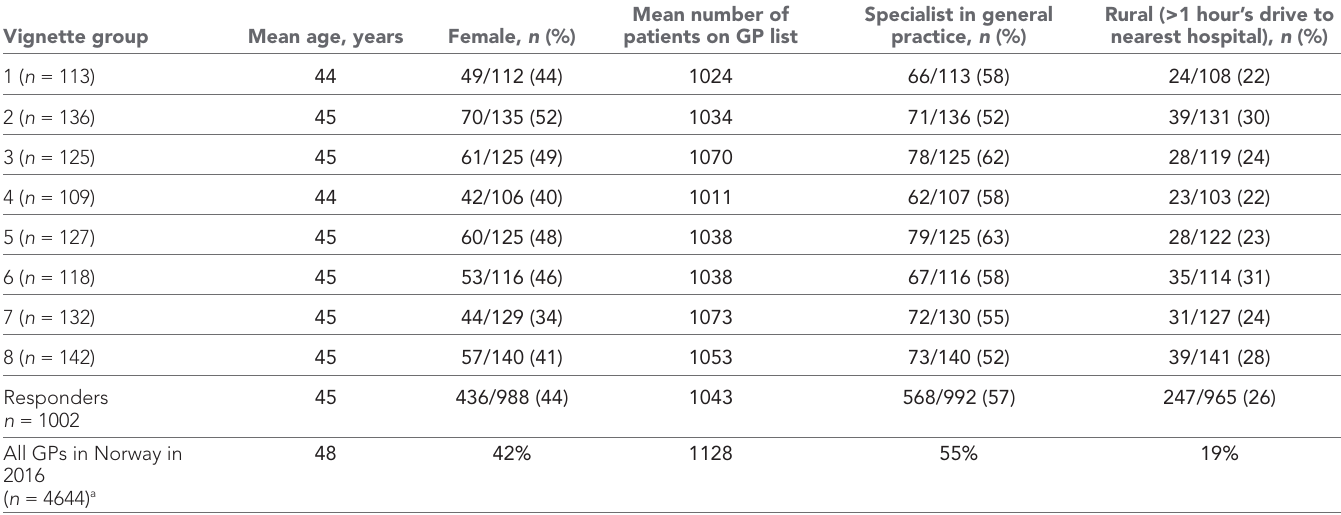
Table 2 Characteristics of responders in the eight vignette